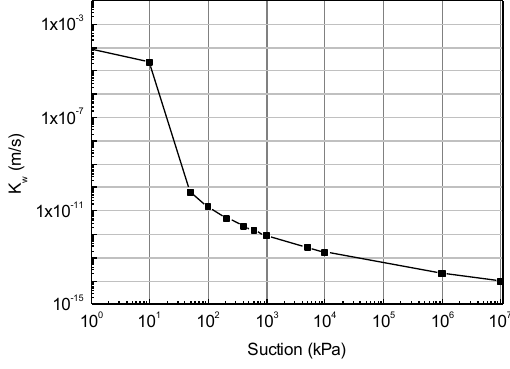
Figure 5b. Hydraulic conductivity (Case Study)